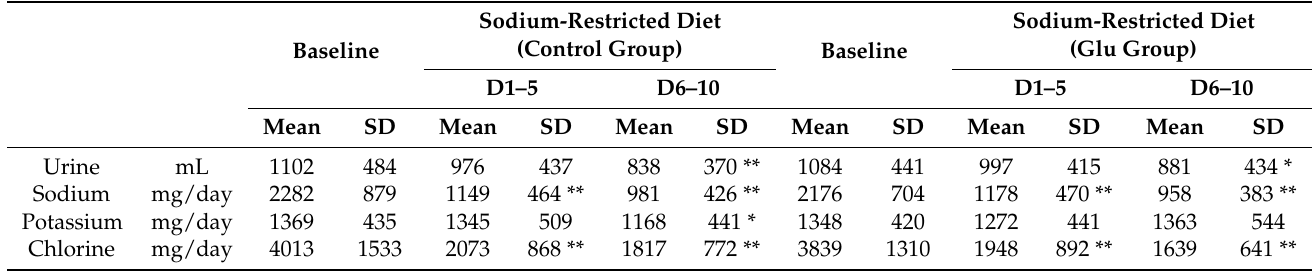
Table 3. Amount of urine, sodium, potassium, and chloride excreted in the baseline and in the sodium-reduced diets.